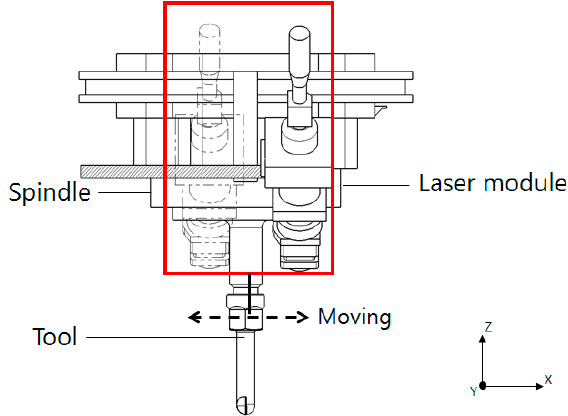
Figure 4. Additional axes of laser module.